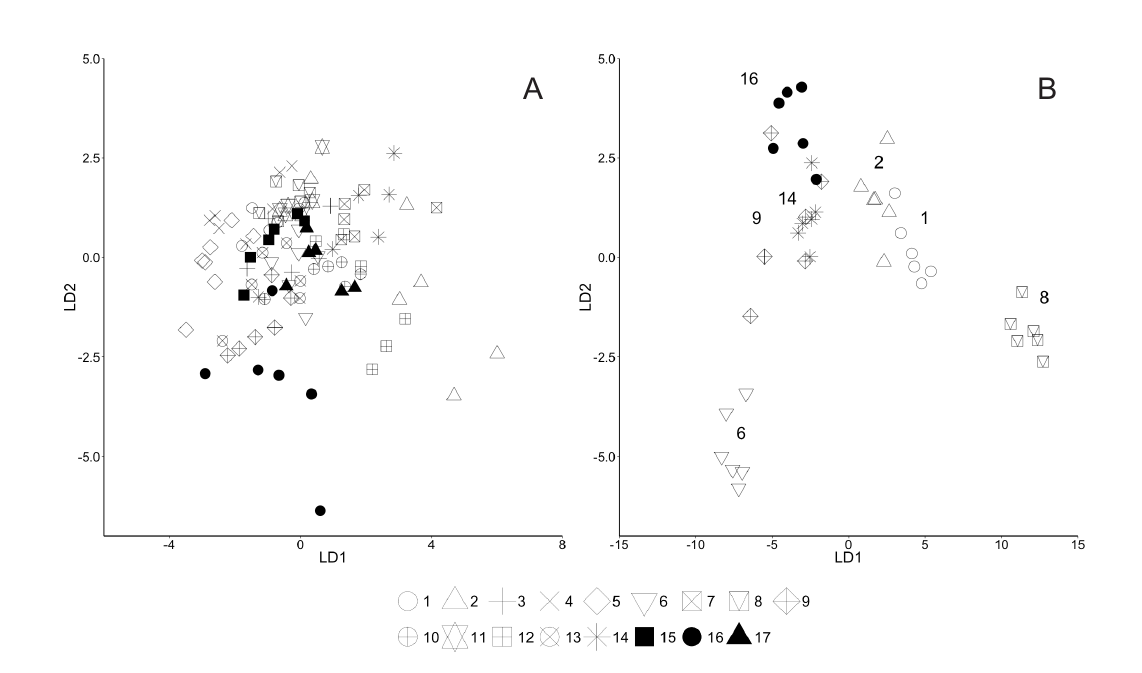
Fig. 4. Linear Discriminant Analysis based on the morphology. A . Scyphistomae (17 cultures) of Aurelia congeners. B . Ephyrae (7 of the 17 cultures) of Aurelia congeners. In each case, cultures can be distinguished from one another by different symbols and corresponding numbers (see